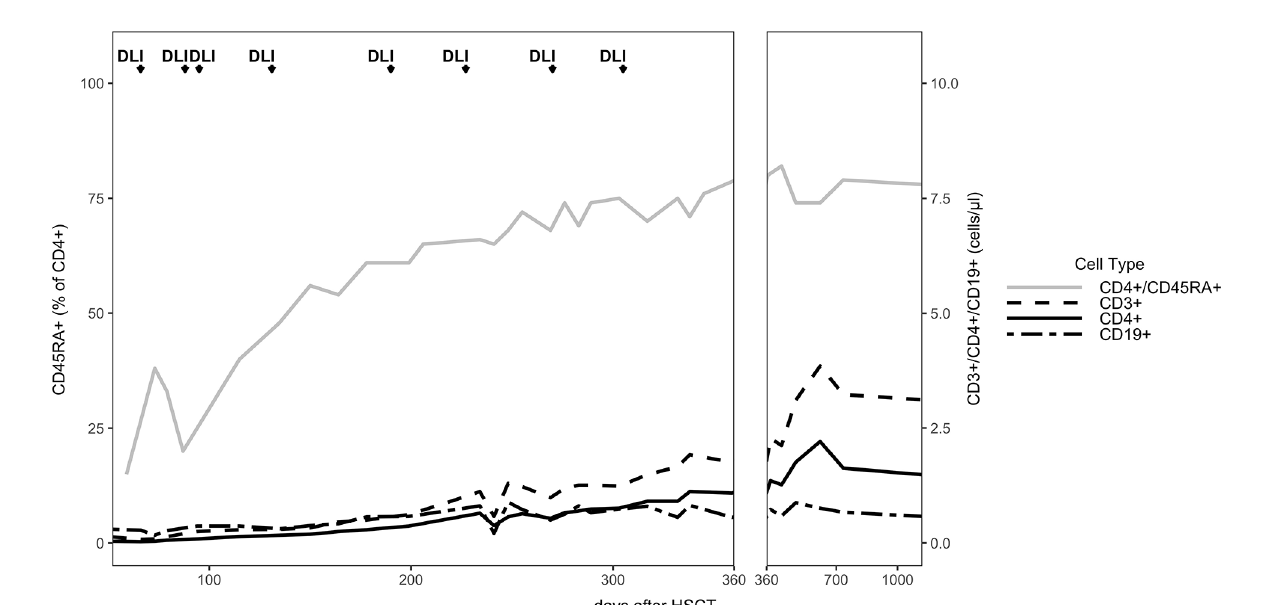
FIGURE 3 Immune reconstitution: The absolute cell numbers per m l are shown for the entire follow up time of 3 years. The CD45RA+ (CCR7+) percentage of the CD4 + cells are shown.